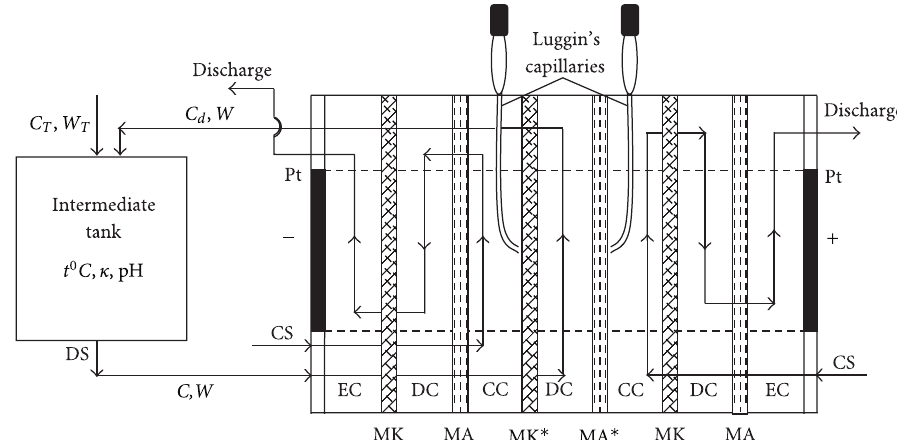
Figure 2: Principal scheme of the experimental setup used for measuring mass-transfer characteristics. A desalting (DS) and two con- centrating (CS) streams, desalination (DC), concentration (CC) and electrode (EC) channels, and polarizing platinum electrodes (Pt) are shown. Dashed straight lines mark out the active section of membrane stack polarized by electric